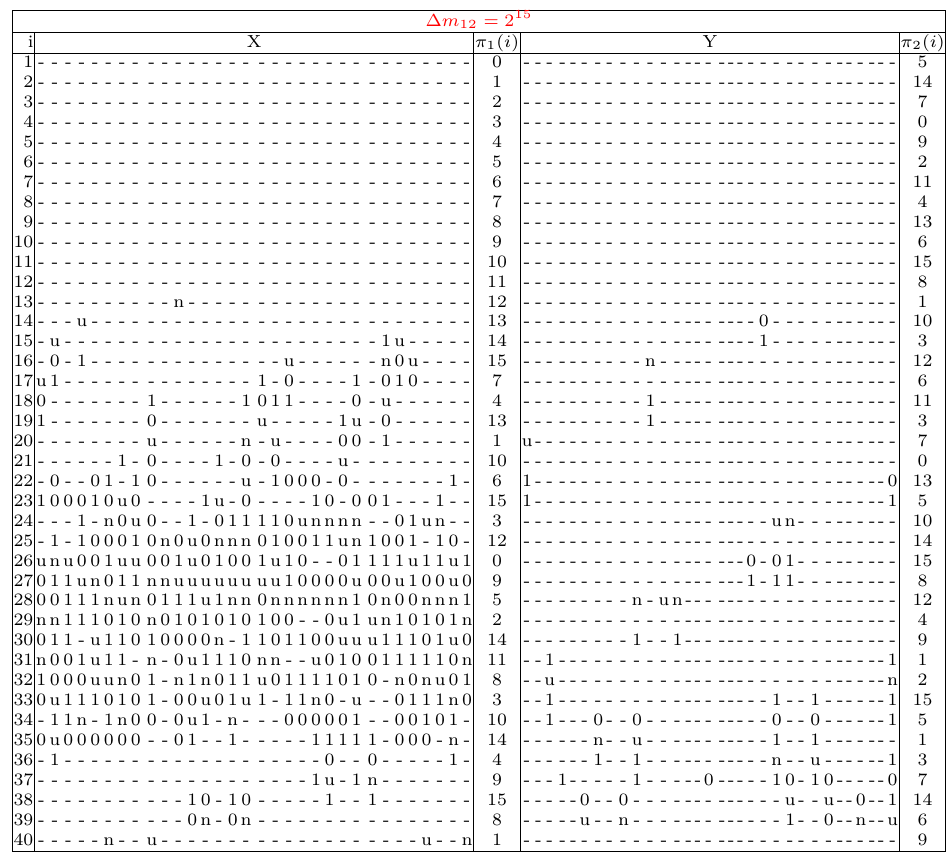
Table 15: 40-step differential